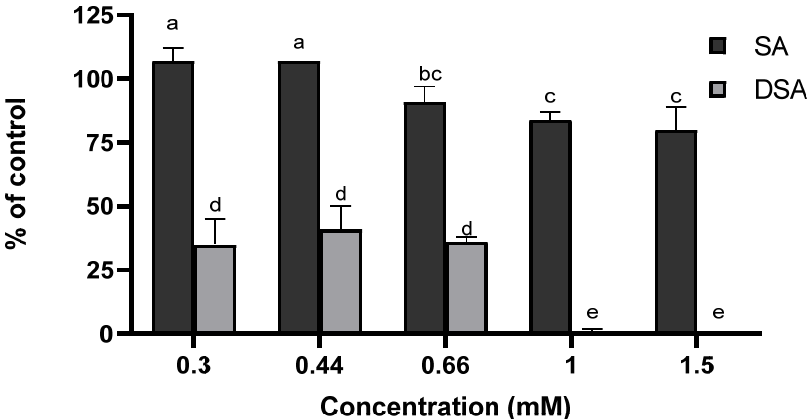
Figure 4. Effects of DSA and SA on the biofilm formation of Pectobacterium brasiliense Pb1692. Biofilm formation was measured after 72 h of growth in LB medium (with the compounds or with water) at 28 °C. Bars ± SE represent the absorbance of crystal violet dye (bound to the biofilm cells) measured at 590 nm. Bars labelled with the same letter are not significantly different from one another ( p < 0.005). Each data point represents the mean ± SE of 6 replicates per treatment and 3 independent experiments. One-way ANOVA with post hoc Tukey HSD tests was used to analyze the differences. Bars that are not labeled with the same letter are significantly different from each other ( p < 0.05). The analysis was conducted using GraphPad Prism